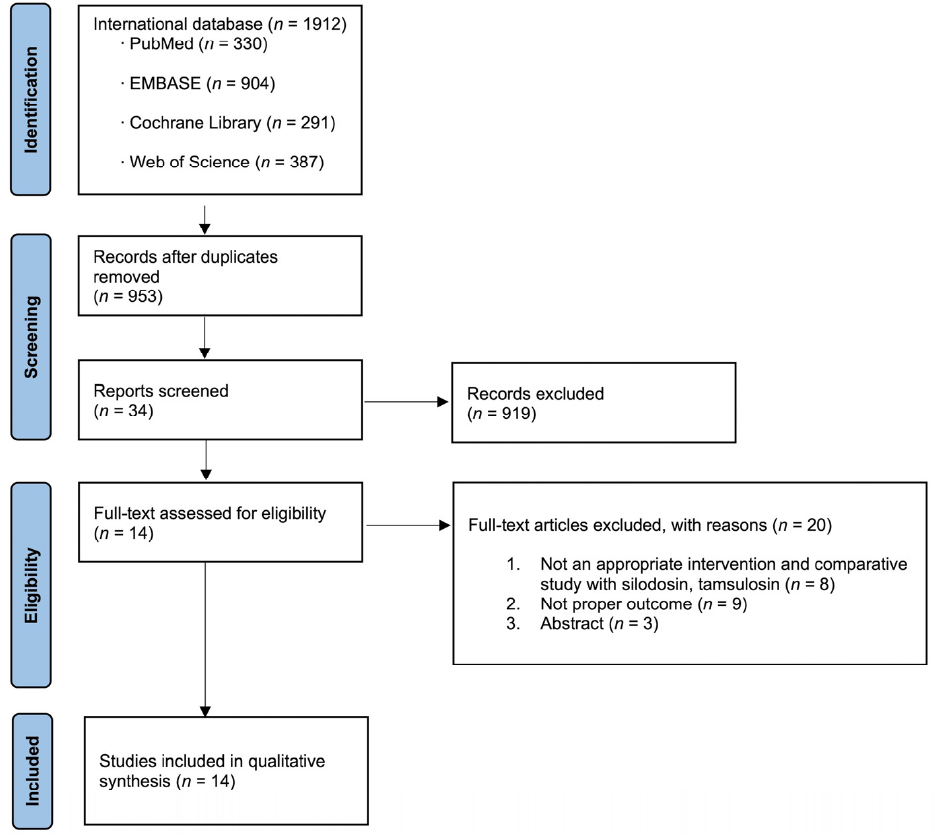
Figure 1. Study flow chart.